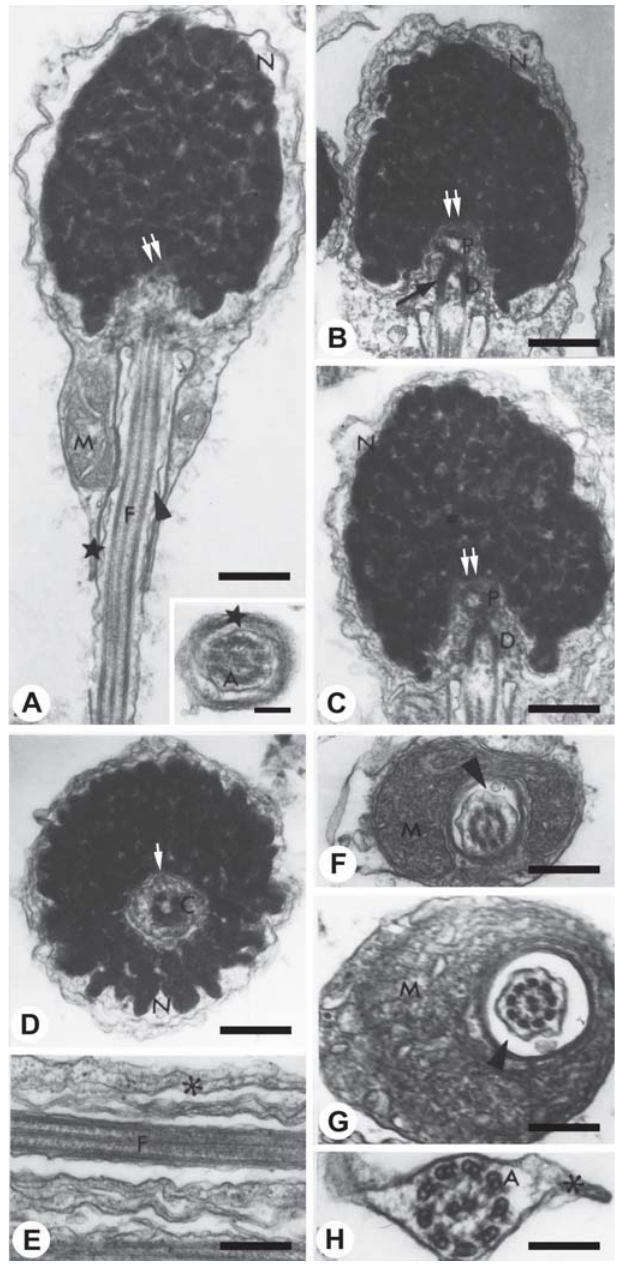
Fig. 2. Piaractus mesopotamicus spermatozoa. A - Longitudinal section of a spermatozoon. A/Inset - Cross section of the midpiece at the cytoplasmic sleeve region. B and C - Longitudinal sections of the nucleus at the nuclear fossa region. D - Cross sections of the nucleus at the nuclear fossa region. E and F - Cross sections in different levels of the midpiece. G and H - Longitudinal and cross sections of the flagellum. Scale bars, A = 0.45 µ m; A/inset = 0,15 µ m; B and C = 0.4 µ m; D = 0.35 µ m; E = 0.3 µ m; F = 0.25 µ m; G = 0.3 µ m; H = 0.15 µ m. A: axoneme; C: centriole; D: distal centriole; F: flagellum; M: mitochondria; N: nucleus; P: proximal centriole; Asterisk: fins; Arrow: electron dense material; Arrowhead: cytoplasmic canal; Double arrow: nuclear fossa; Star: cytoplasmic